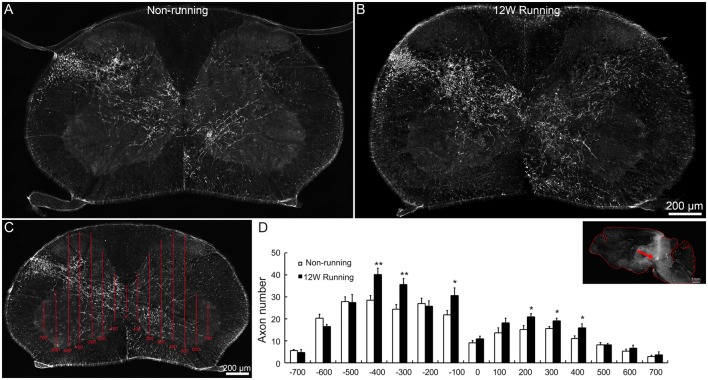
Projections of red nuclei to the spinal cord are increased after training. (A,B) Upon biotinylated dextran amine (BDA) injections in the red nucleus, well stained axons are widely distributed in the dorsolateral white matter and the entire gray matter contralateral to the injection side, and some cross the midline and innervate the ipsilateral gray matter, both in runners (A) and non-runners (B). (C,D) Quantitative assessment of axon extension shows that, after 12 weeks (12W) of training, the number of grid crossing is significantly increased at contralateral (indicated as −400, −300 and −100 μm away from the midline) and ipsilateral levels (indicated as 200, 300 and 400 μm away from the midline) in runners in comparison to non-runners. *P < 0.05; **P < 0.01; n = 3 for each group. The insert in (D) showed the injection site (arrow).